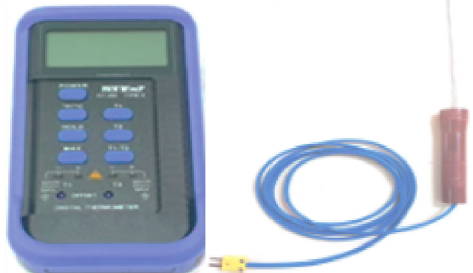
Figure 2: Digital thermometer merk HotTemp